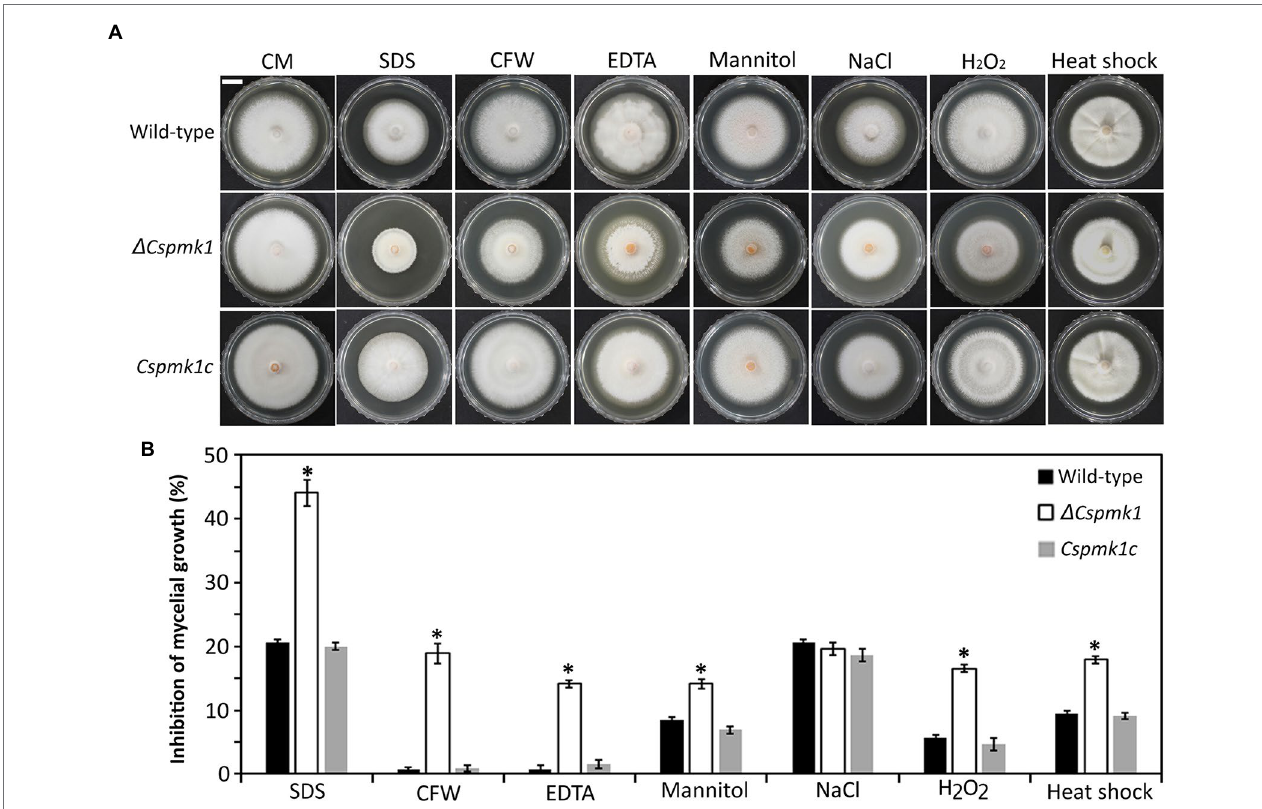
FIGURE 1 | CsPMK1 is involved in stress adaptation. (A) Mycelial growth of the indicated strains on CMA amended with chemical and thermal stresses. Three- day-old mycelial agar plugs (5 mm in diameter) were inoculated into complete medium agar (CMA), and cultured at 28 ° C, and into CMA containing 0.005% sodium dodecyl sulfate (SDS), 3,000 ppm calcofluor white (CFW), 1 mM ethylenediaminetetraacetic acid (EDTA), 1 M mannitol, 0.4 M NaCl, and 5 mM H 2 O 2 and cultured at 25 ° C. Photographs were taken after 6 days. Scale bar, 1 cm. (B) Inhibition of mycelial growth under chemical and thermal stresses. Inhibition of mycelial growth was calculated based on colony diameter of on CMA and CMA amended with stresses. Significant differences in a group indicated with esthetic star ( * ) were estimated using Duncan’s test ( p <